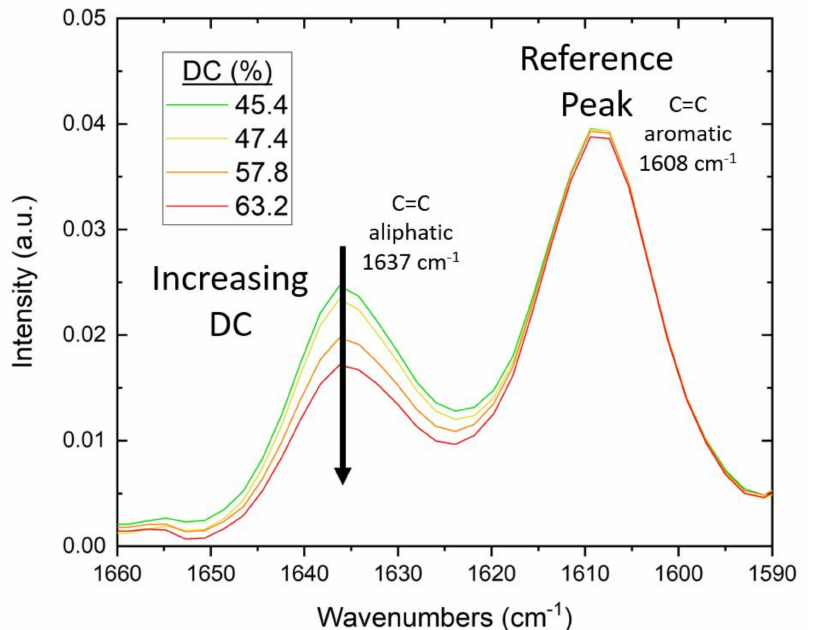
Figure 3. Example of change in FTIR spectra with increasing DC of Bis-EMA photopolymers. As the (meth)acrylate pendant groups react during curing, the intensity of the aliphatic C=C peak at 1637 cm − 1 decreases.